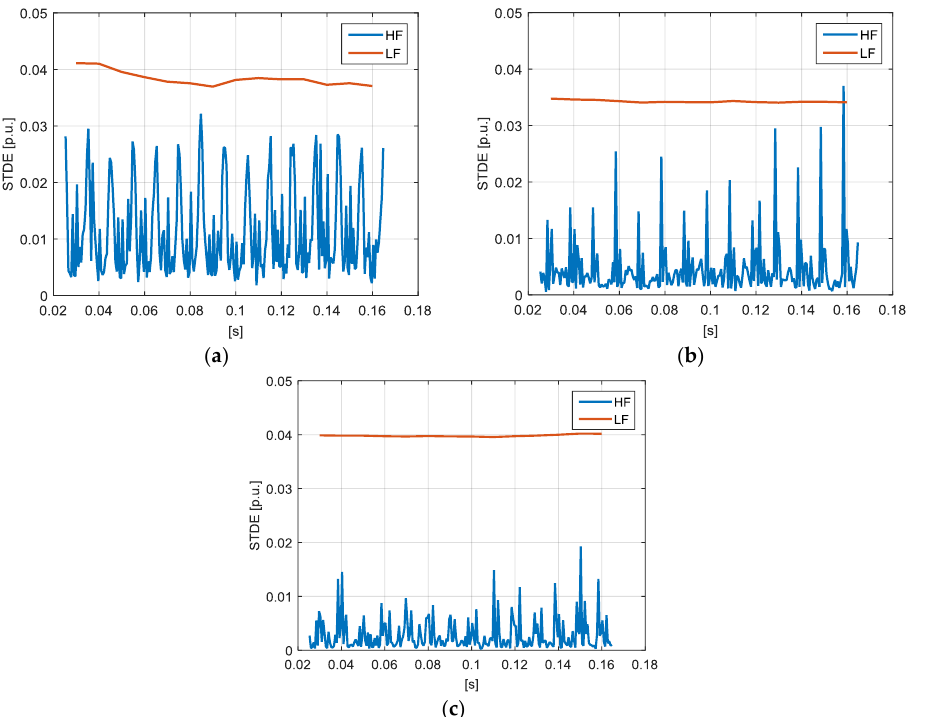
Figure 48. Case study 4: STDE at low-frequency (0 ÷ 2 kHz, red line) and at high-frequency (2 ÷ 150 kHz, blue line) obtained for ( a ) one lamp, ( b ) ten lamps, and ( c ) forty-eight lamps.